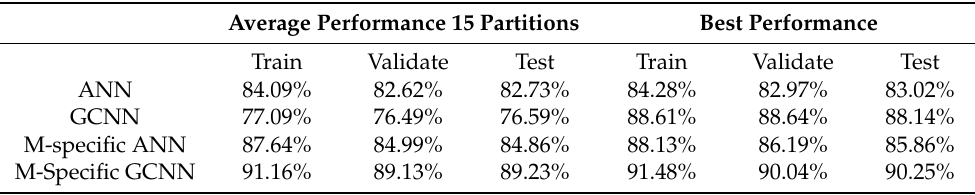
Table 4. Performance of ANN and GCNN models using all cell types and macrophage-specific ANN and GCNN models for COVID-19 infection severity